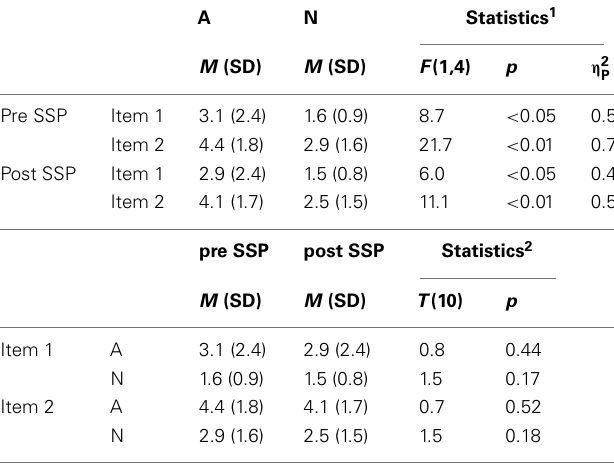
Table 3 | Exposure of alcohol and control